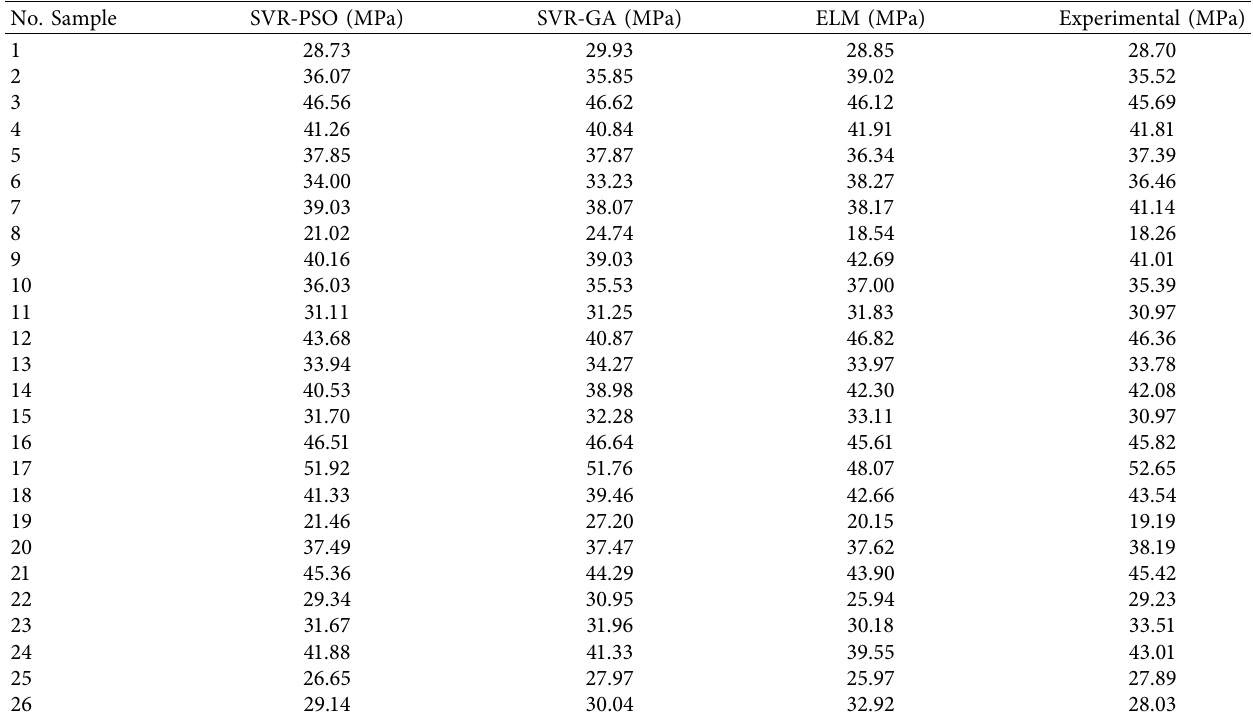
Table 4: The predicted compressive strength values using applied models versus the experimental values during the testing phase.